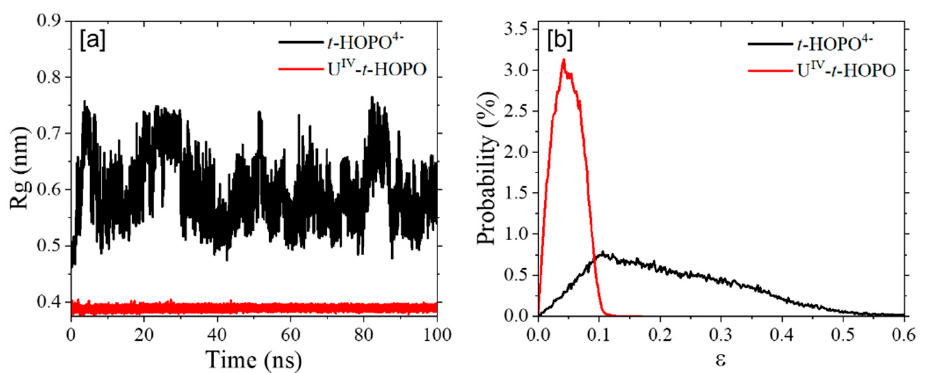
Figure 10. ( a ) The radius of gyration (Rg) and ( b ) eccentricity ( ε ) of t -HOPO 4 − and U IV - t -HOPO com- plex.